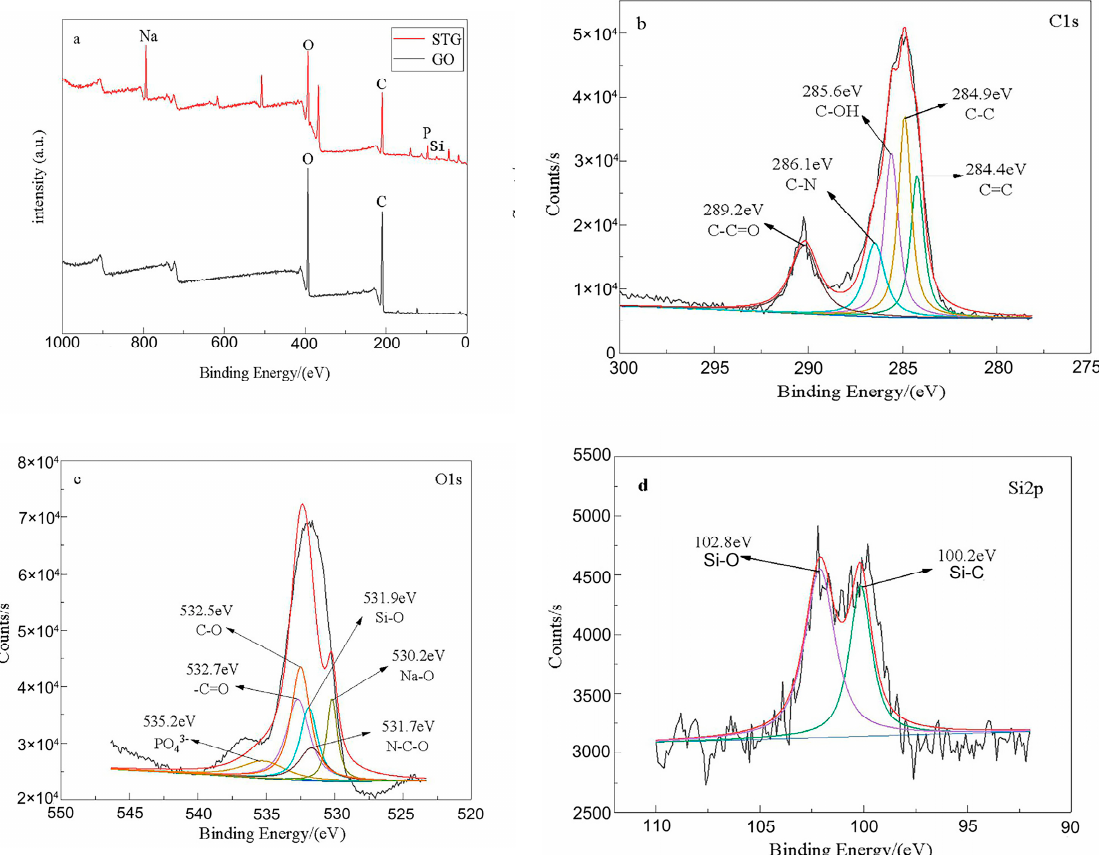
Figure 3. ( a ) XPS full spectra of GO and STG; ( b ) C 1 s spectrum of STG; ( c ) O 1 s spectrum of STG; ( d ) Si 2 p spectrum of STG.